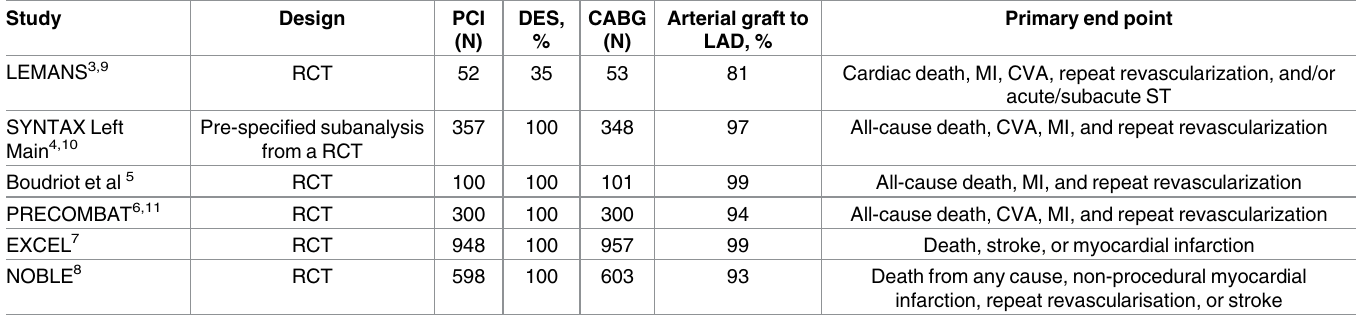
Table 1. Features of included studies. CABG: Coronary artery bypass graft; CVA; cerebrovascular accident; DES: drug eluting stent; LAD: left anterior descending; MI: myocardialinfarction;PCI: percutaneous coronaryintervention;RCT: randomised controlledtrial.